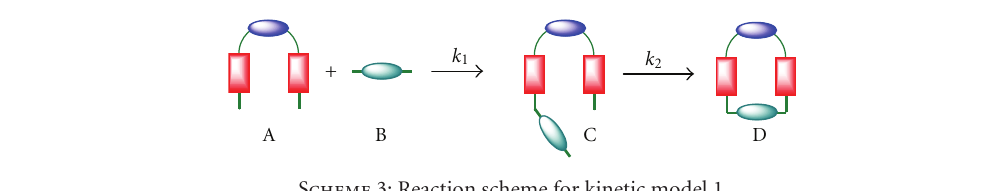
Scheme 3: Reaction scheme for kinetic model 1.